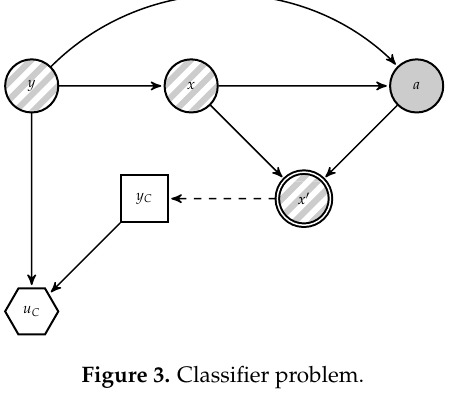
Figure 3. Classifier problem